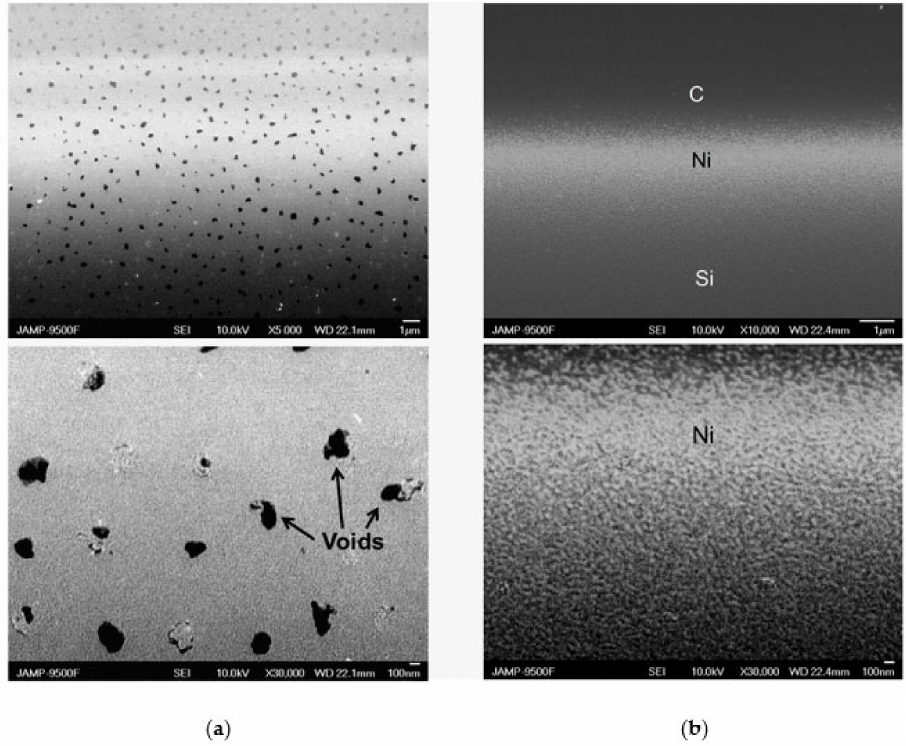
Figure 6. Cross-sectional SEM images of Ni ( a ) and Ni-C 60 ( b ) samples. Lower images enlarge the middle parts of the upper images.